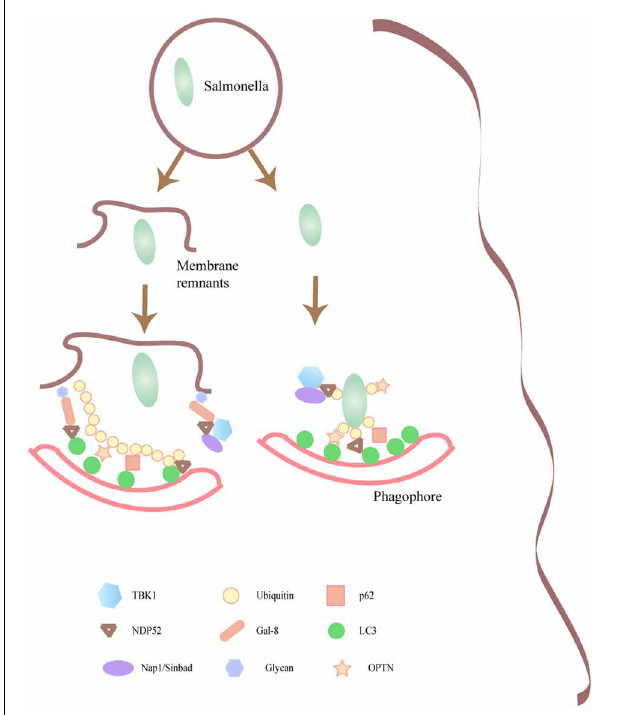
FIGURE 2 | Intracellular pathogens that damage the containing phagosomal membrane are targeted by autophagy. Molecular components responsible for the targeting of certain microorganisms toward the autophagy pathway are depicted. Several of the autophagic adaptors such as p62, NDP52, that participate in the recognition of Salmonella by the autophagic machinery are